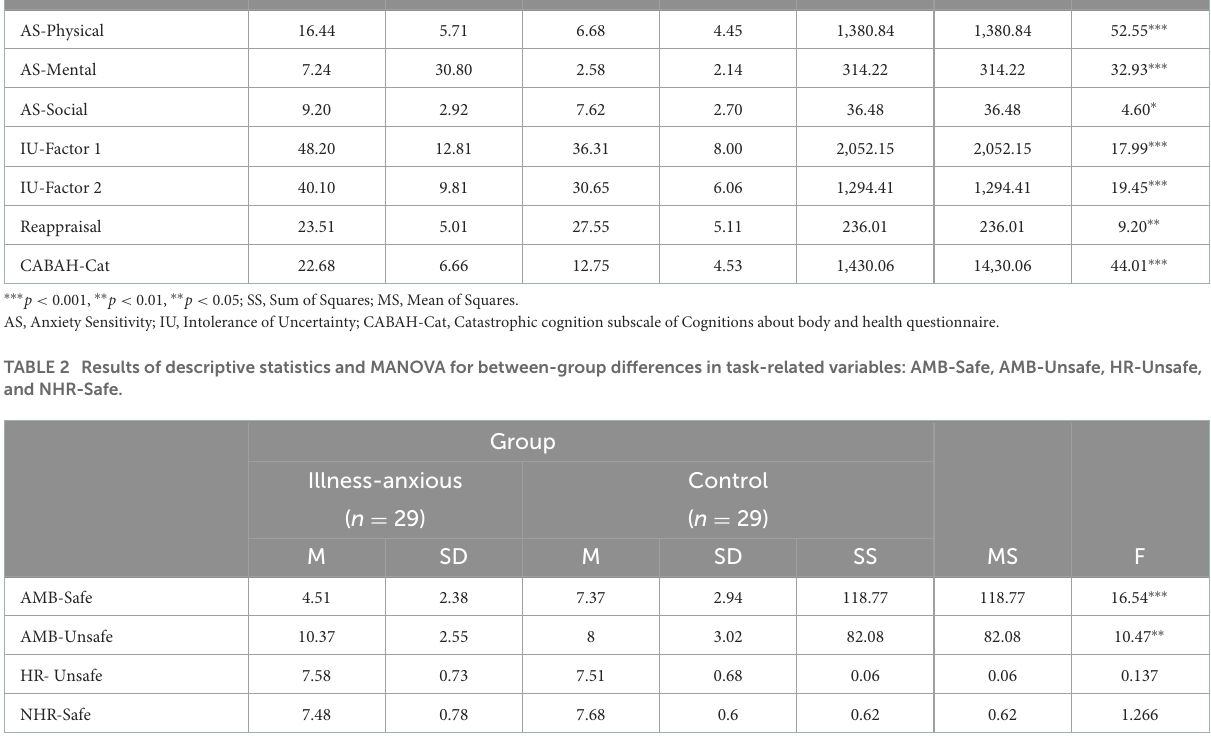
TABLE 1 Results of descriptive statistics and MANOVA for between-group differences in self-report variables: AS-physical, AS-mental, AS-social, IU-Factor 1, IU-Factor 2, reappraisal, and CABAH-Cat. Group